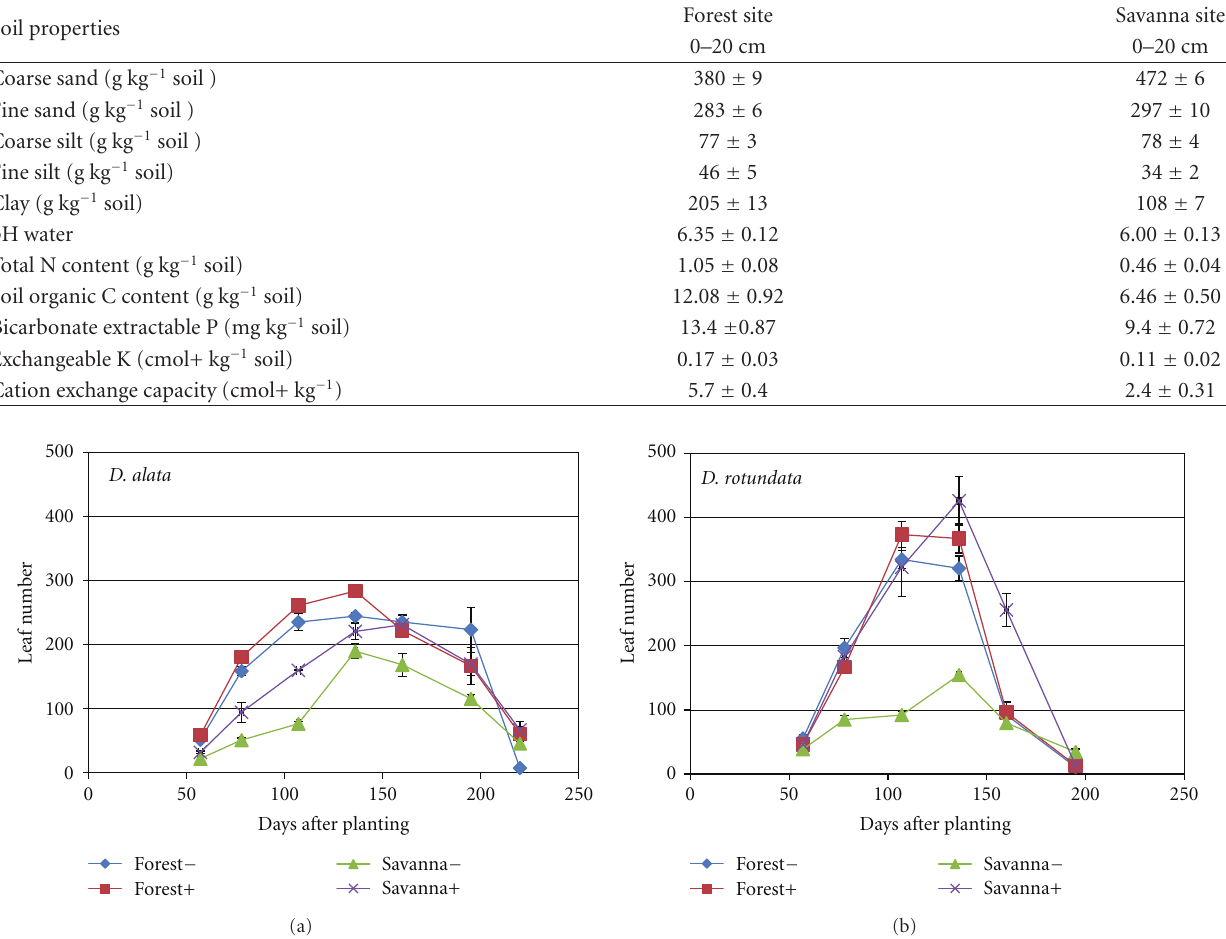
Figure 1: Leaf number of Dioscorea spp. grown in a forest and savanna sites with (+) and without ( − ) fertilizer application. Error bars represent standard error of